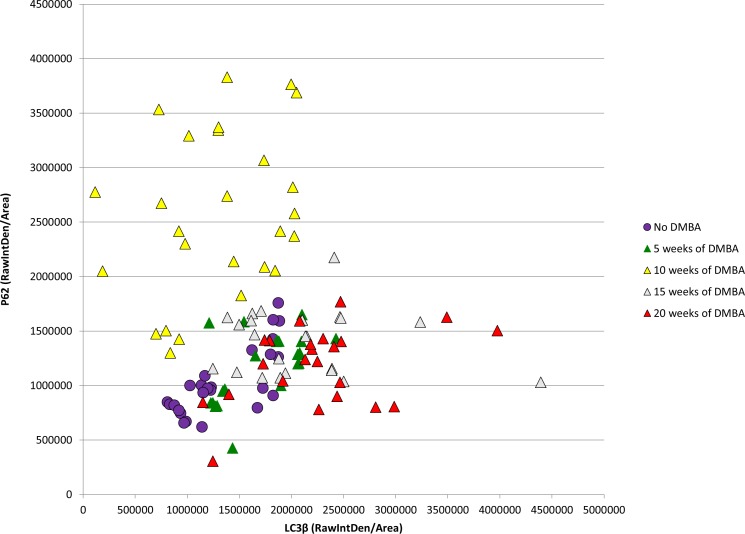
LC3β and p62 immunofluorescence levels in K14E6/E7 mice over DMBA treatment time course as determined by FIJI analysis.ANOVA analysis demonstrated a statistically significant increase in p62 levels at 10 weeks of DMBA treatment (yellow triangles) compared to all other treatment groups, indicating a blockage of autophagic degradation function. There was also a statistically significant increase in LC3β in the 15 and 20 week DMBA treated mice compared to no DMBA treated mice, demonstrating a significant increase in autophagic induction at these two time points. 10 weeks of DMBA treatment also showed an increase in LC3β levels compared to no treatment controls, but it did not reach statistical significance. The above graph shows that mice at the 10 week DMBA treatment time point (yellow triangles) are very different from the other treatment groups in terms of evidence of autophagic dysfunction.